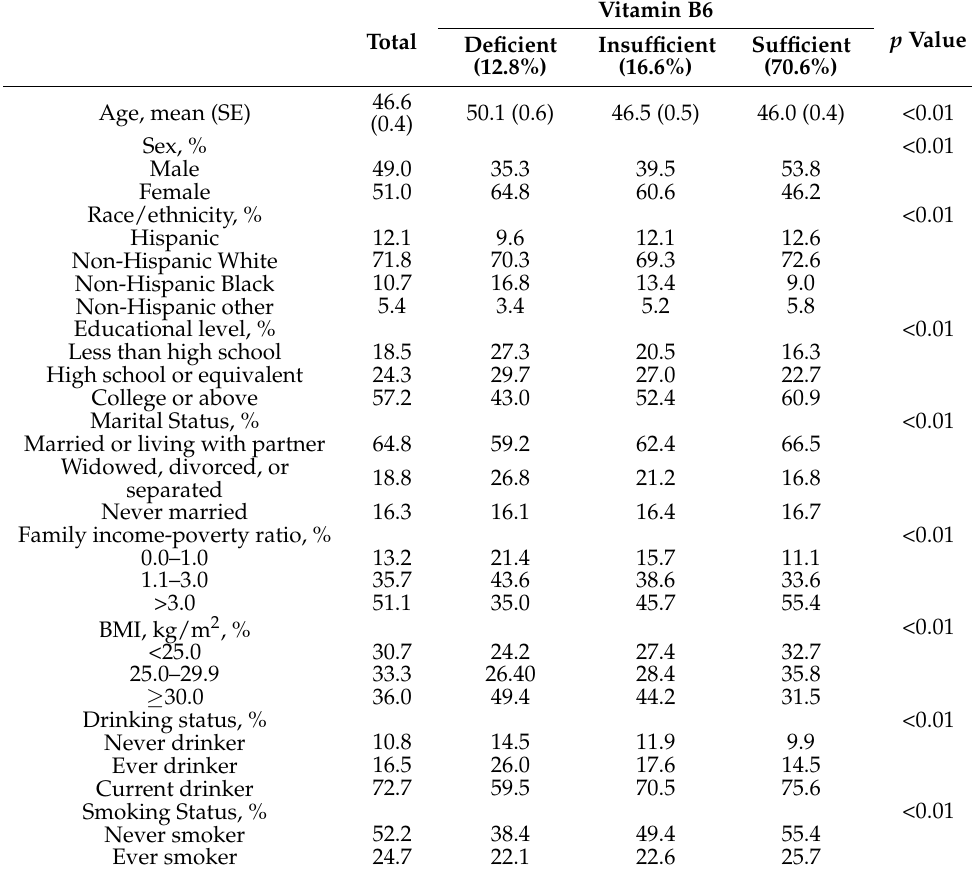
Table 1. Baseline characteristics of participants in NHANES from 2005 to 2010 a .